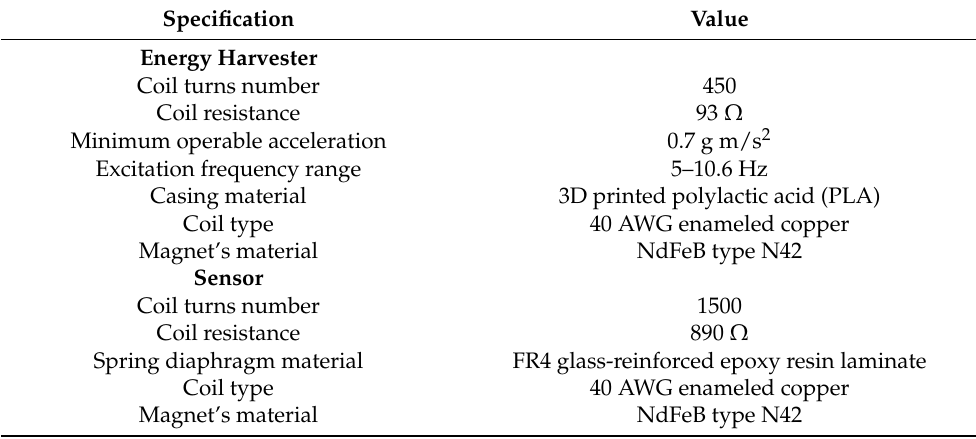
Table 1. Specification and details of the fabricated energy harvester-sensor unit.